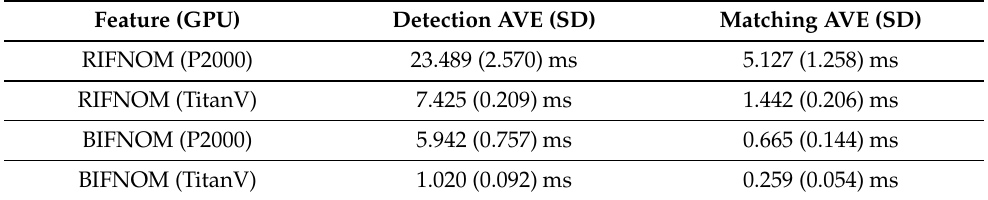
Table 1. Computation time for interest point detection and matching. The entries, “AVE” and “SD”, are average and standard deviation, respectively.